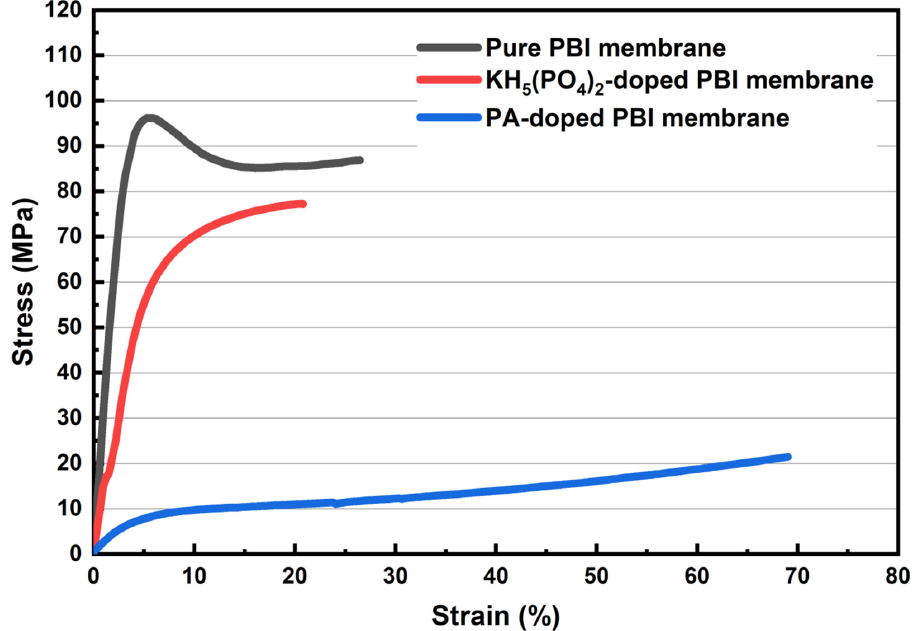
Figure 5. Stress-strain curves of the pure PBI membrane, KH 5 (PO 4 ) 2 -doped PBI membrane, and PA-doped PBI